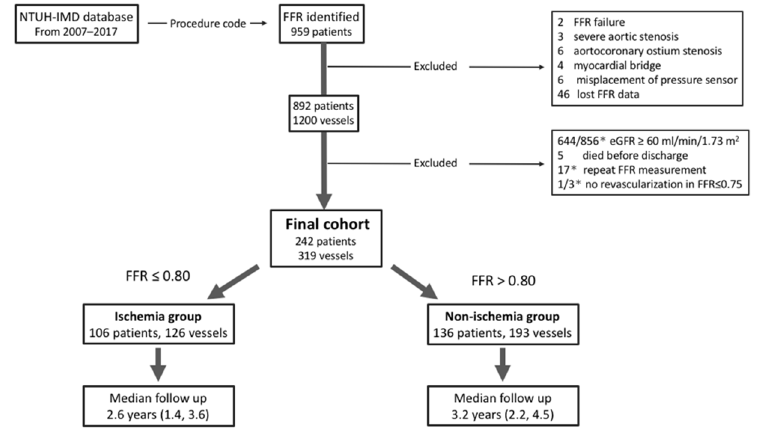
Figure 1. Diagram of patient flow. The final cohort consists of 242 patients; 44% have functional ischemia with FFR ≤ 0.8. * Counts as per vessel, otherwise count as per person. Abbreviations: eGFR, estimated glomerular filtration rate; FFR, fractional flow reserve; NTUH-IMD, National Taiwan University Hospital integrated medical database.